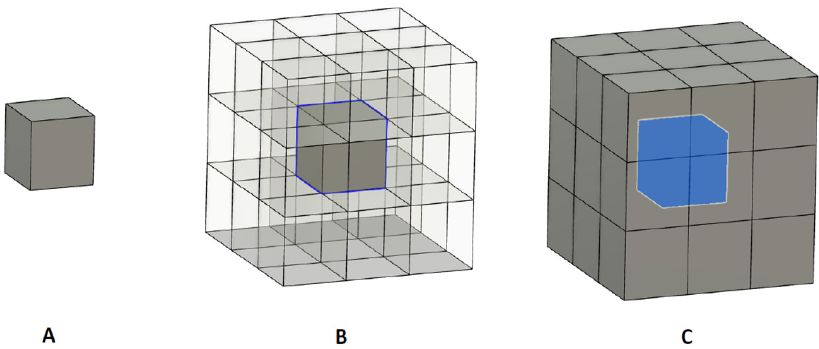
Figure 7. ( A ): Single voxelized point; ( B ): 3 × 3 × 3 structuring element with origin in central point; and ( C ): result of dilatation operation.